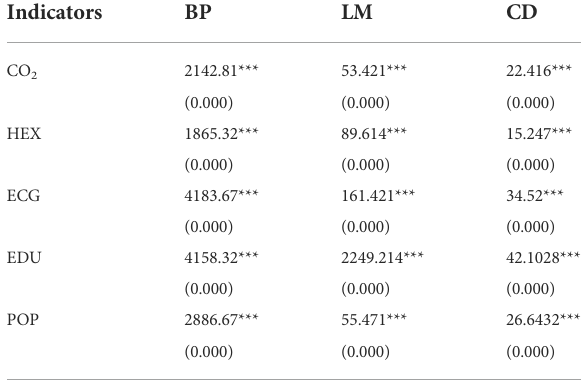
TABLE 2 The Pesaran et al., 2004 CSD test.